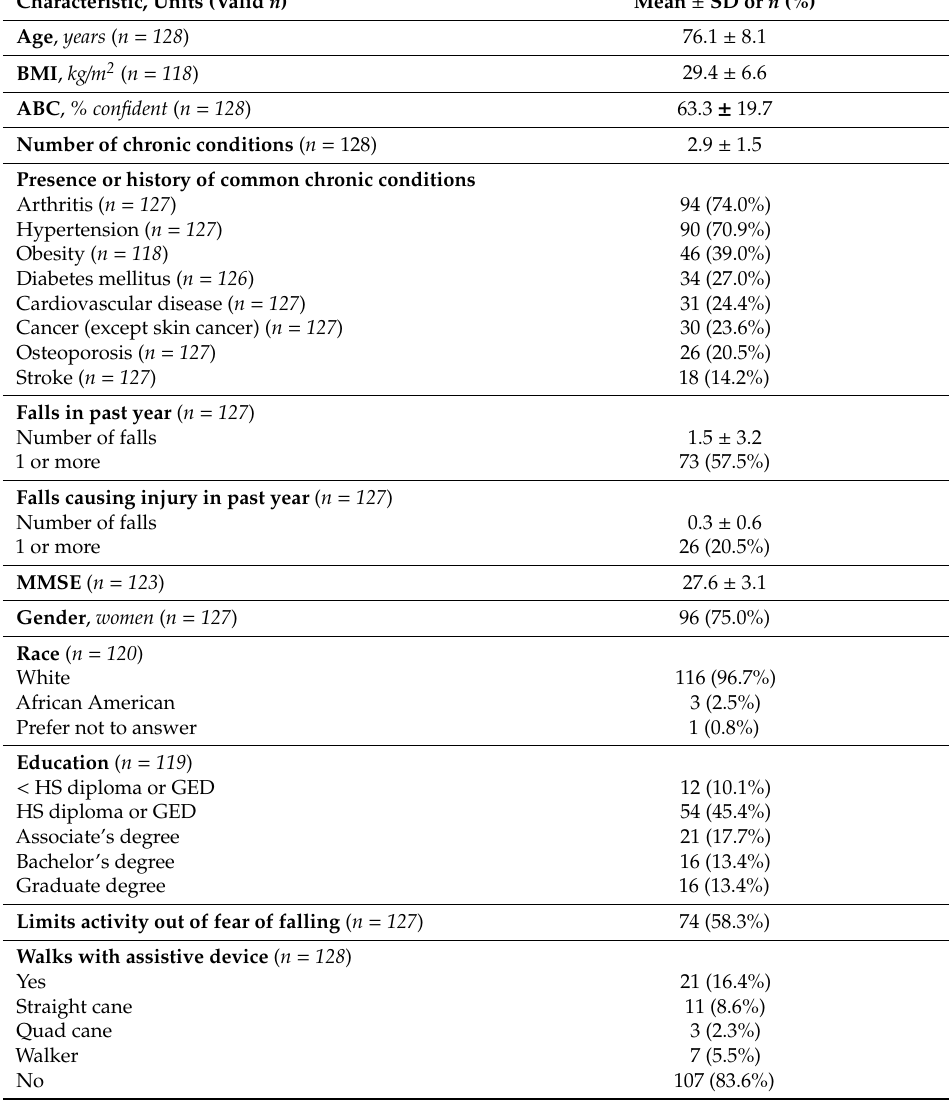
Table 1. Baseline Characteristics of Participants ( n =